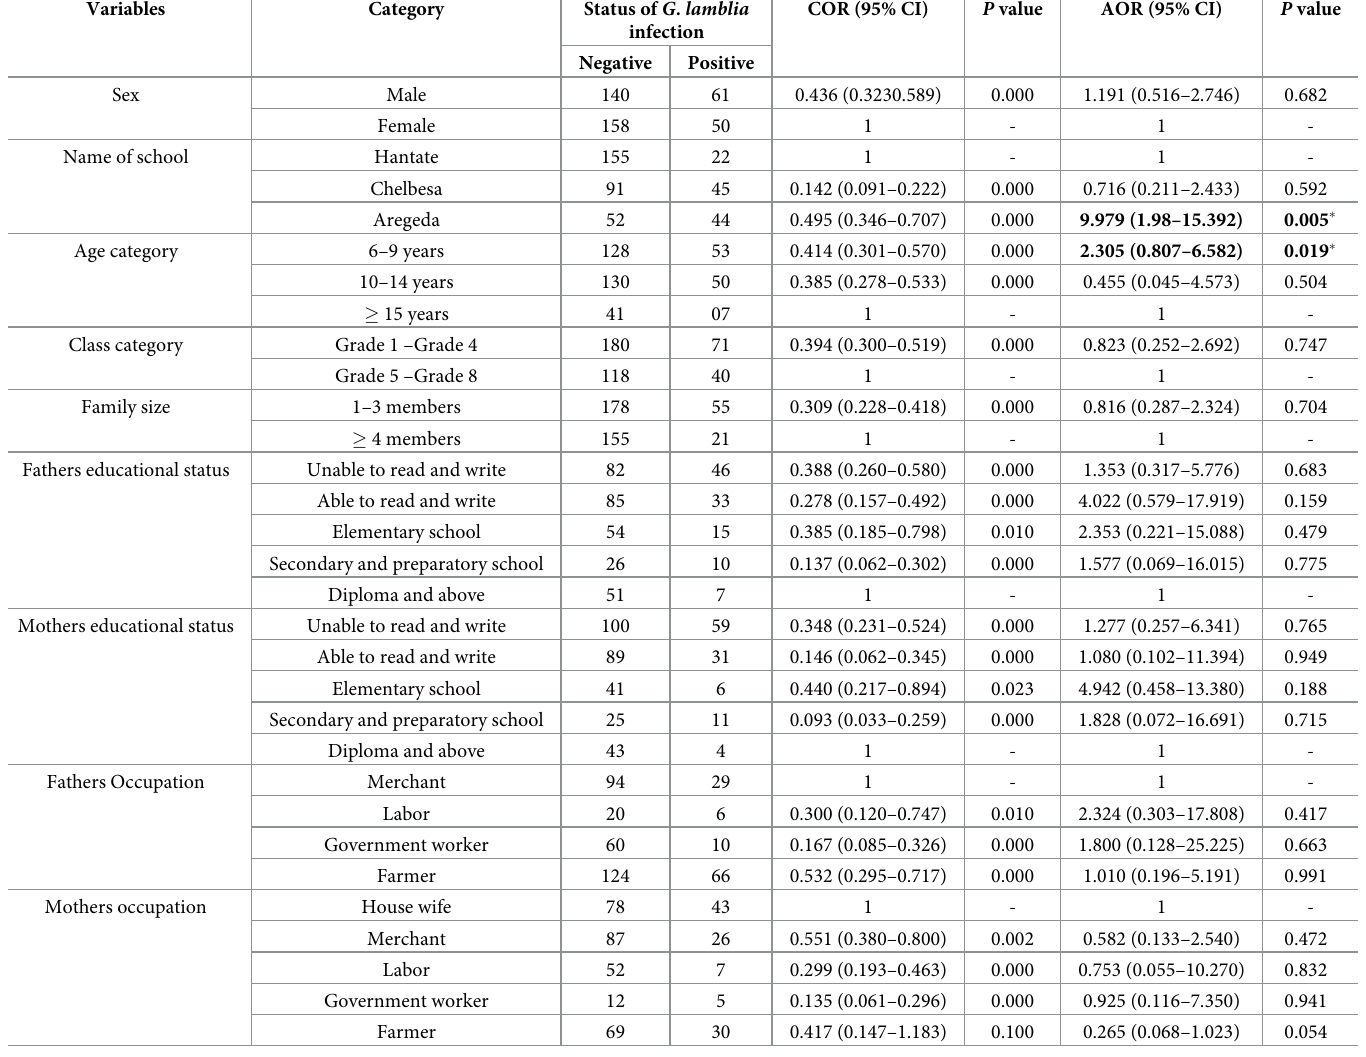
Table 4. Bivariate and multivariate analysis of socio-demographic factors of G . lamblia infections from government elementary school students of Lok Abaya town, Sidama zone, SNNPR, Ethiopia.